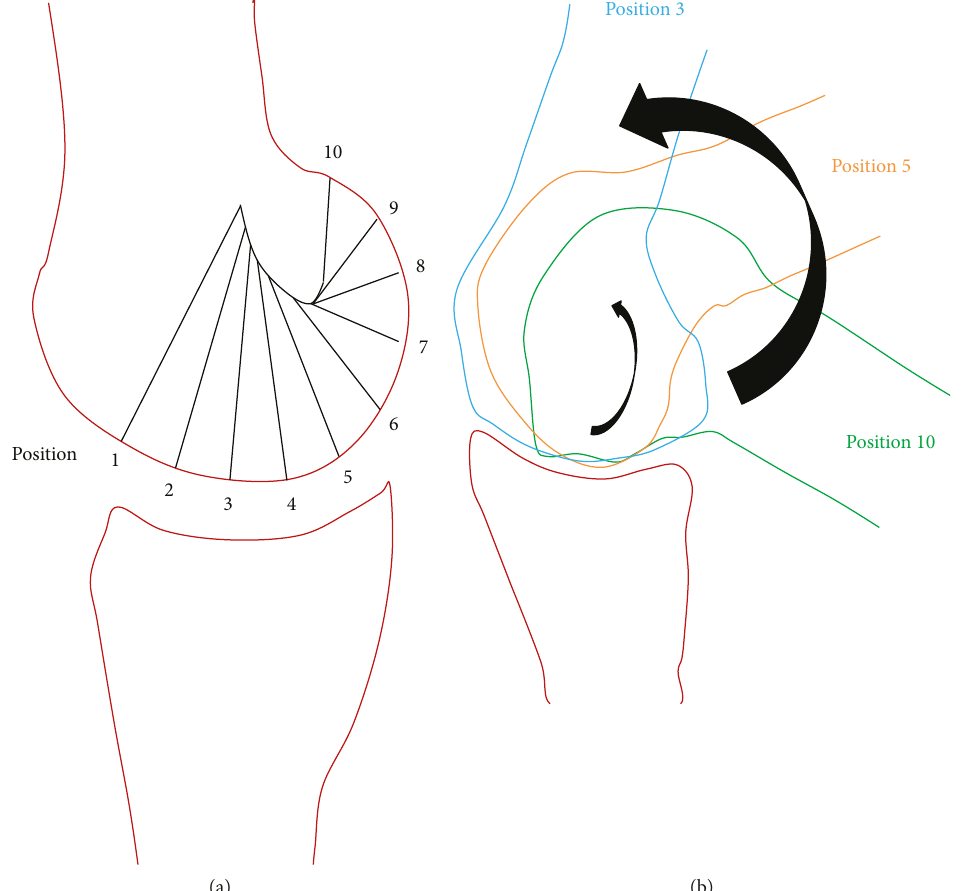
Figure 6: (a) Illustrating the change in the center of rotation (CoR) of the femur over the tibia (positions 1 to 10) (dotted lines indicate radii of rotation). (b) Arbitrarily selected anatomical positions during rotation.